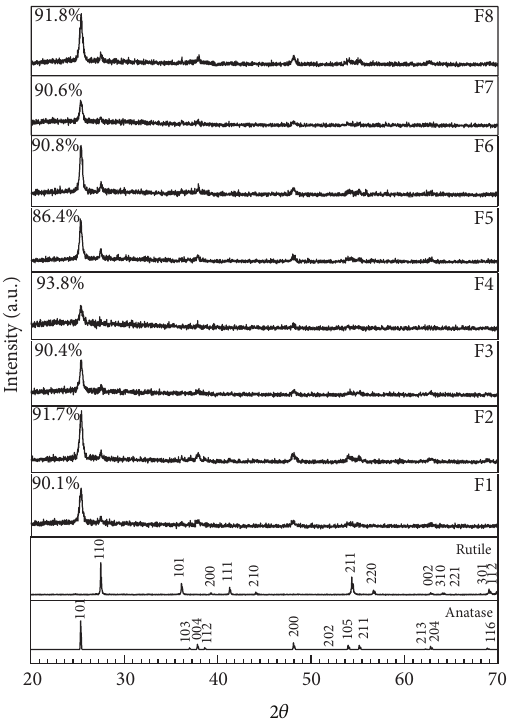
Figure 2: XRD patterns of TiO 2 films formed using the 2 3 experimental design. The reference anatase and rutile patterns were obtained from RRUFF R060277 and RRUFF R040049, respectively.